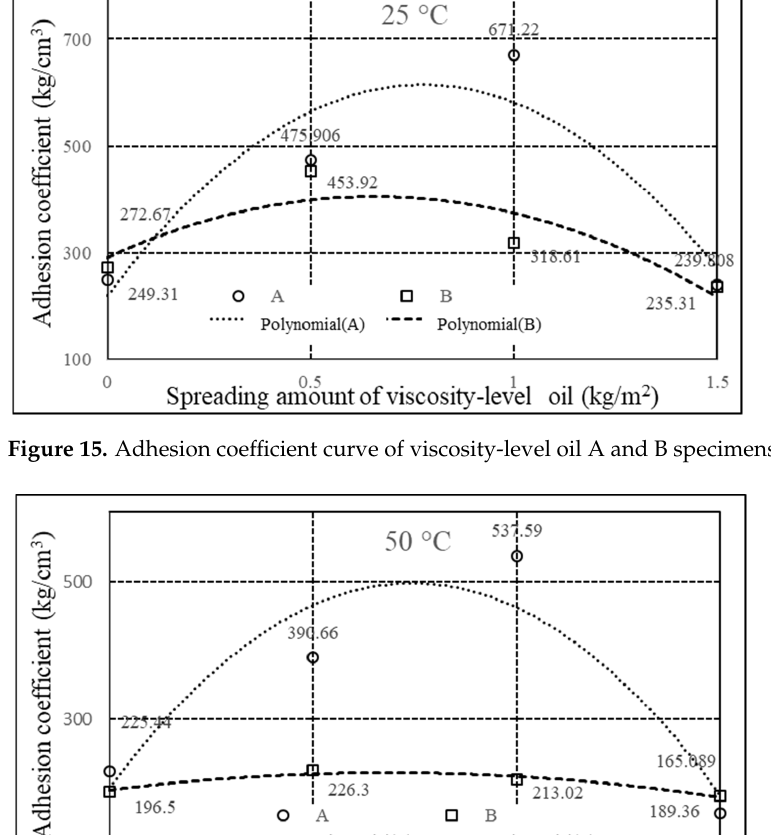
Figure 14. Adhesion coefficient curve of viscosity-level oil A and B specimens at 0 °C.